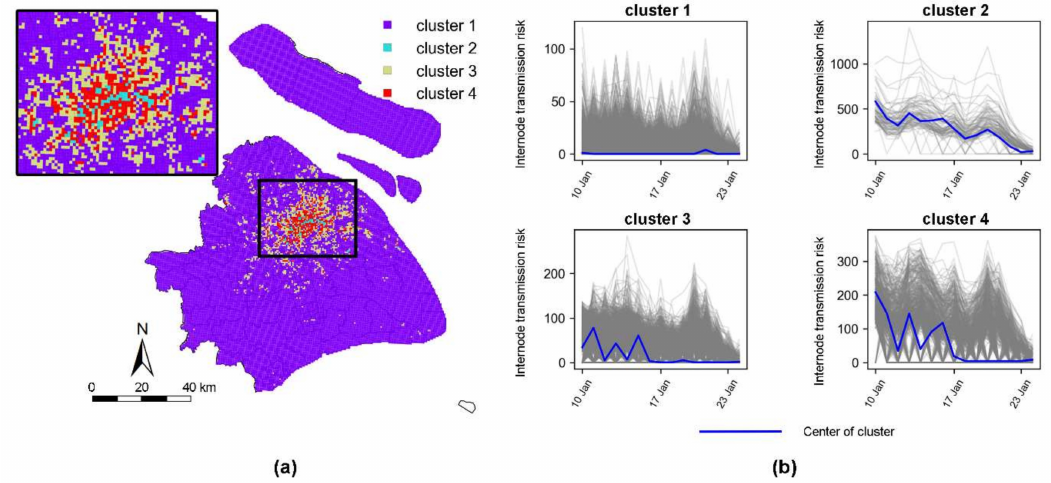
Figure 8. Spatial distribution of internode transmission risk ( a ) and the corresponding time series ( b